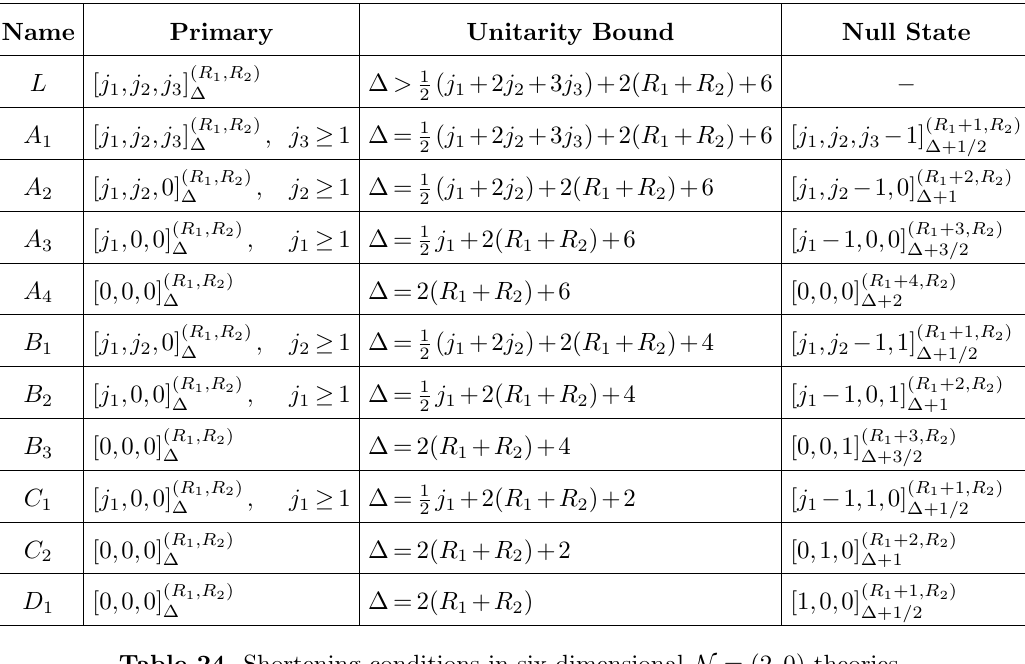
Table 24 . Shortening conditions in six-dimensional N = (2 ; 0)